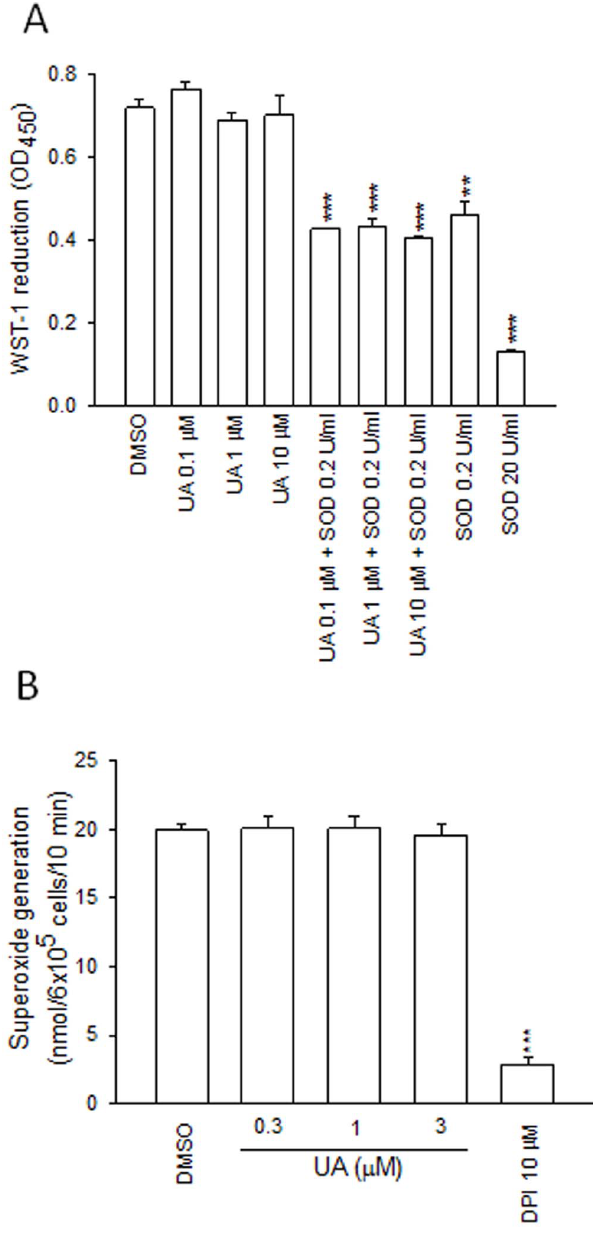
Figure 3. Effects of ursolic acid (UA) on superoxide anion production in a cell-free xanthine/xanthine oxidase system. (A) Reduction of WST-1 was determined in the presence of UA with or without superoxide dismutase (SOD). (B) A reactive mixture of the neutrophil cytosolic fraction and membrane fraction was preincubated with DMSO, UA (1, 3, and 10 m M), or diphenyleneiodonium (DPI). Data are shown as mean 6 SEM (n=3 or 4). *** p , 0.001 compared to the control.